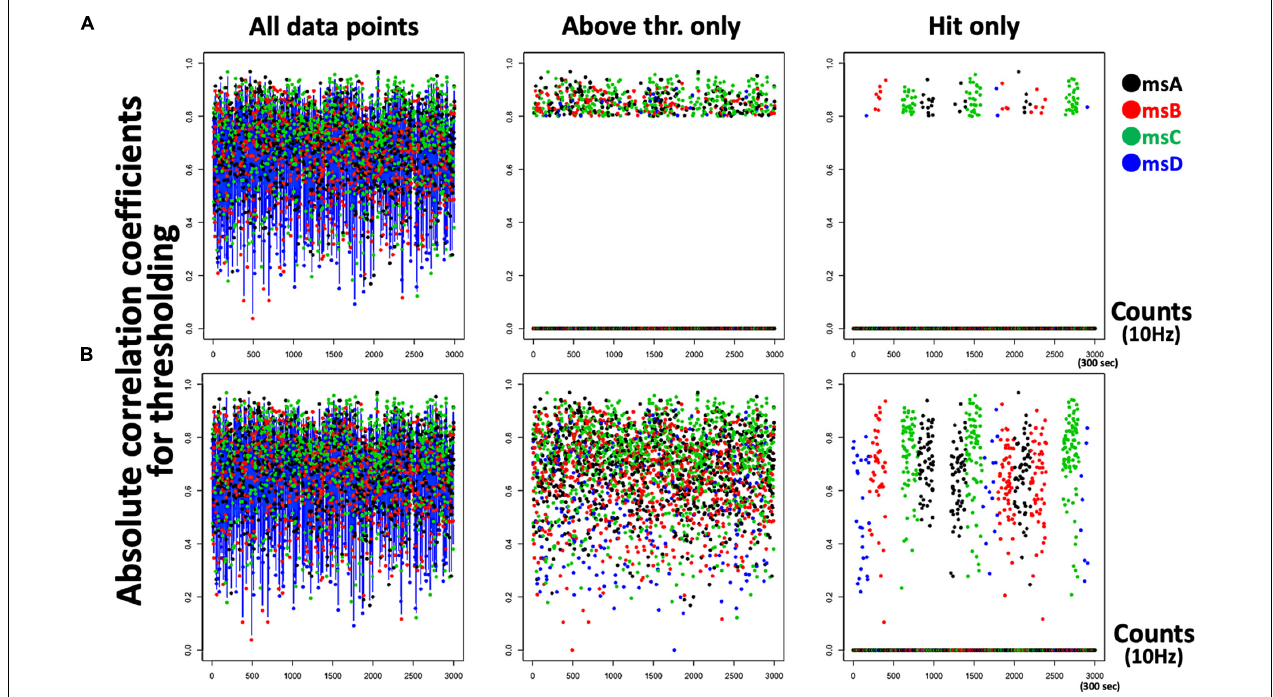
FIGURE 4 | Outputs of the neurofeedback system. (A) A typical scatter plot of a 5-min session (left) showing visually informed (circle feedback) data points only (middle) and auditory-informed “Hits” only (right). (B) If the threshold is lowered (e.g., r thr = 0.1 for comparison), participants receive too much feedback (visual for the middle panel and auditory for the right panel) to